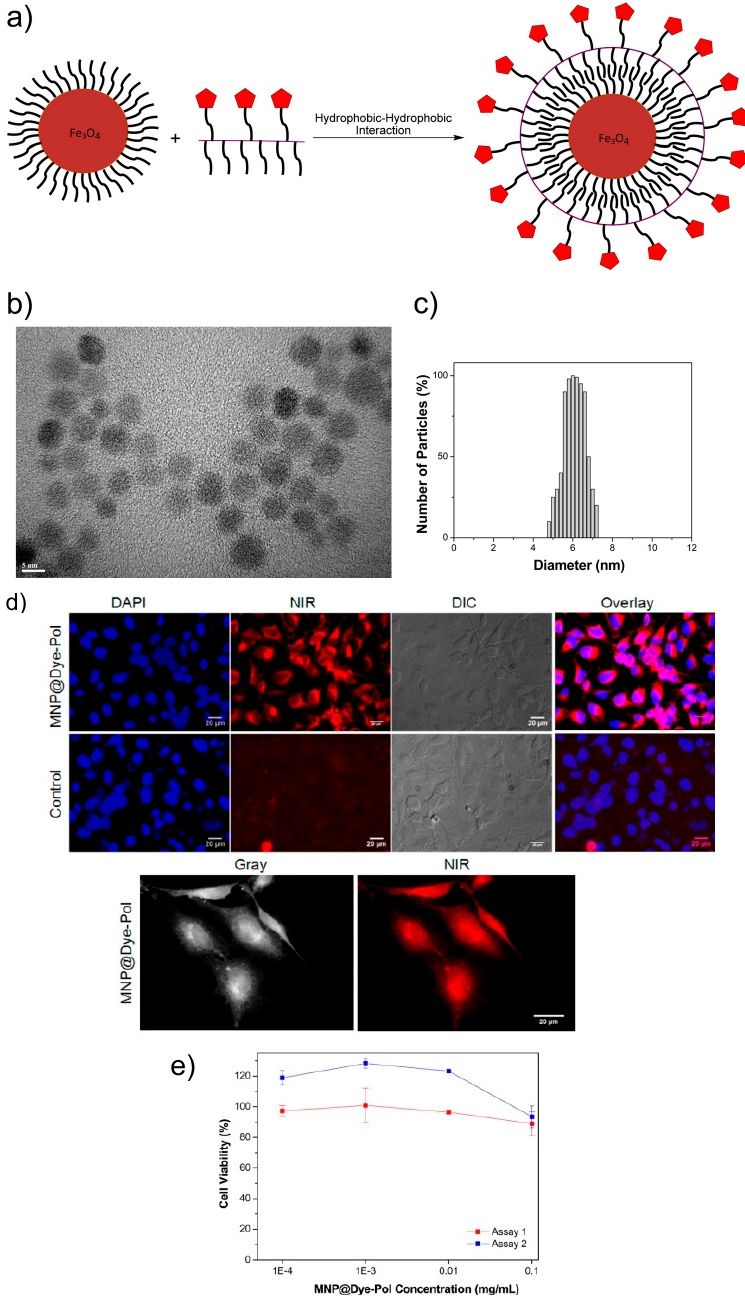
Figure 10. Top: ( a ) Schematic illustration of Dye-Pol-conjugated Fe 3 O 4 magnetic nanoparticles (MNPs) through hydrophobic interaction, yielding MNP@Dye-Pol. ( b ) HRTEM and ( c ) Size-distribution of MNP@Dye-Pol. ( d ) Labeling of HeLa cells incubated for 2 h with 50 μ L of MNP@Dye-Pol (1 mg/mL). Blue (DAPI), red (NIR), and DIC channels. (Lower panel) Images at high magnification. Scale bar: 20 μ m. ( e ) In vitro cell viability of HeLa cells incubated for 24 h (assay 1) and 6 h (assay 2) at 37 °C with different concentrations of MNP@Dye-Pol. Cell viability assays were carried out using CellTiter-Blue in triplicate. The error bars represent the standard deviations. Adapted from ref. [75]. A fluorescent ruthenium (Ru) complex was coupled to magnetic Fe 3 O 4 nanoparticles (NPs) via 3-(3,4-dihydroxyphenyl) propanoic acid (DHPPA) and O , O ′ - bis (2-aminopropyl) polypropylene glycol-block-polyethylene glycol-block-polypropylene glycol (PPG-PEG-PPG-diamine) [77]. Water